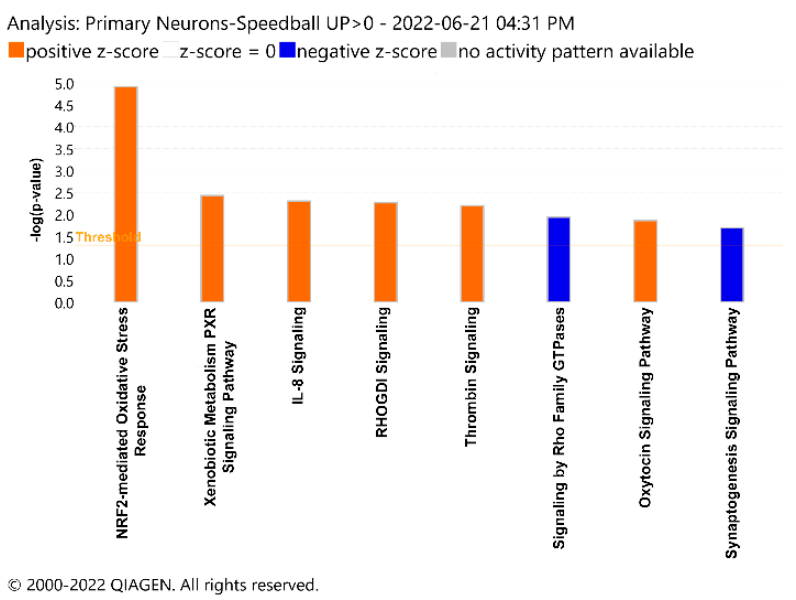
Figure 3. Ingenuity Pathway Analysis. Mapping of dysregulated pathways associated with METH/oxy treatment. Pathways are organized based on the negative log of the p -value. Positive and negative z-scores, represented by orange and blue coloration, suggest increased and decreased pathway activity, respectively.